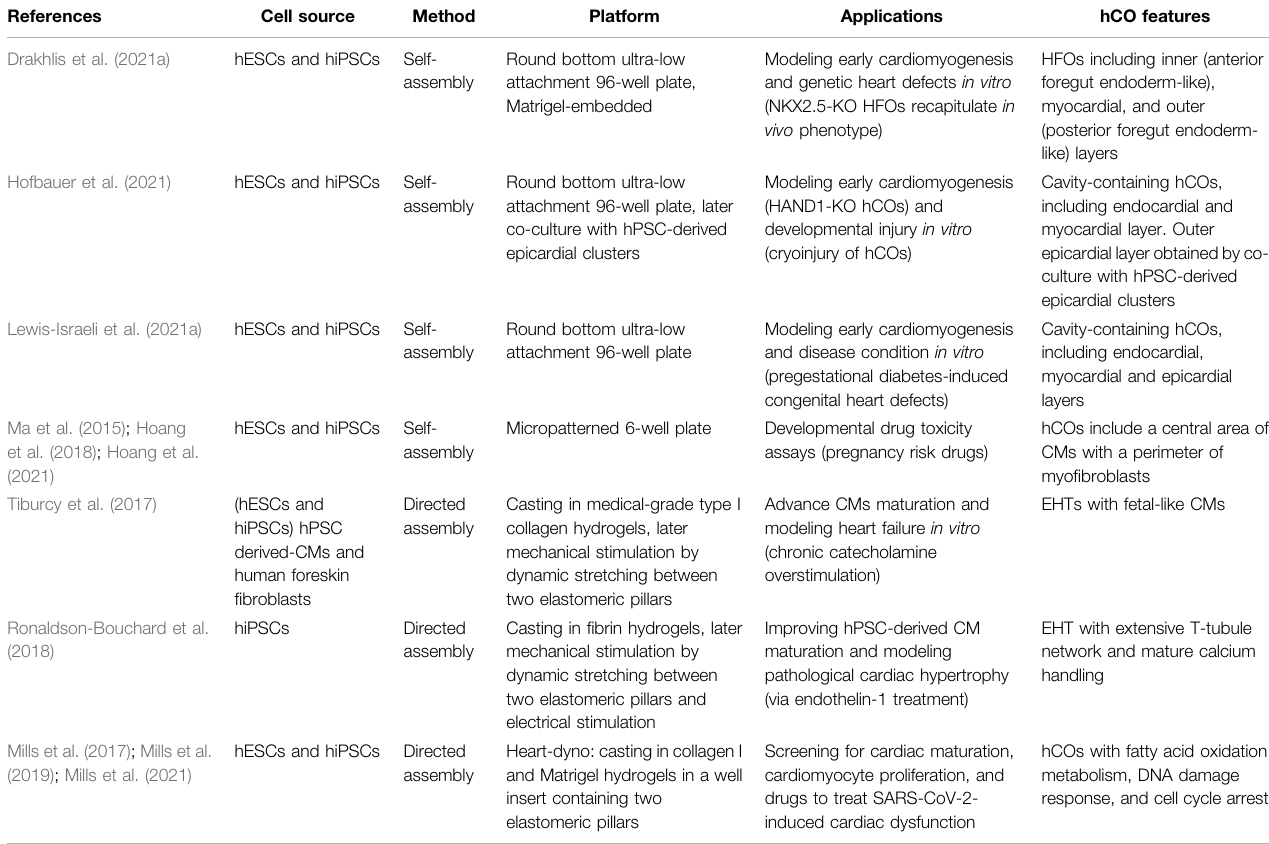
TABLE 1 | Generation of hCOs by the self-assembly and the directed assembly